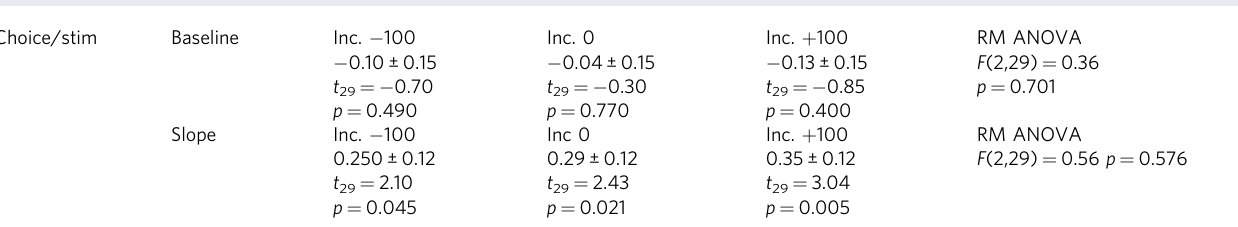
Table 2 Comparison of ventromedial prefrontal cortex (VMPFC) activity at the choice moment ( t values), as a function of incentive